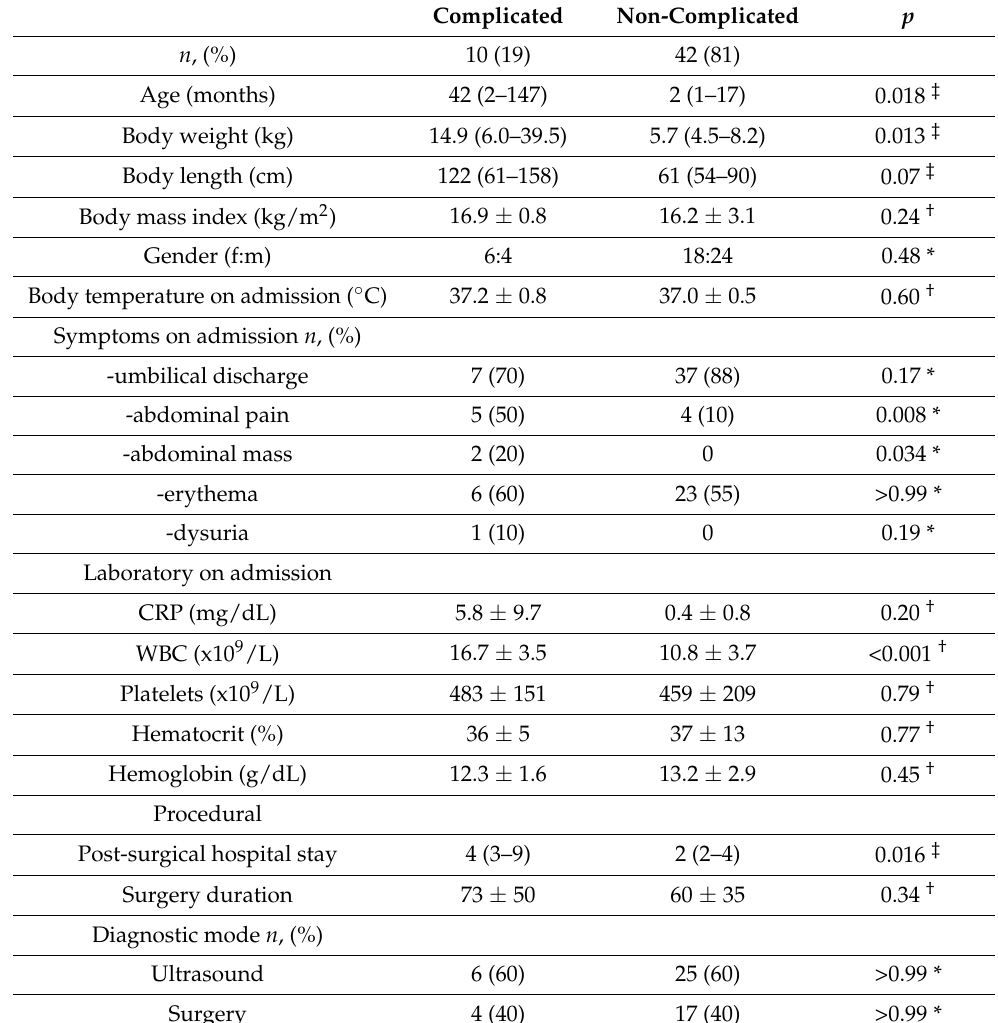
Table 2. Pre- and postoperative complicated versus non-complicated course of urachal anomalies. Complicated